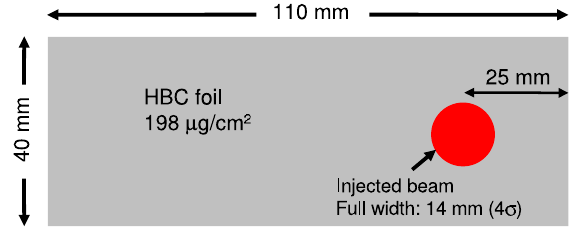
FIG. 4. The first generation primary HBC stripper foil used in the RCS was with a vertical size of 40 mm. The injected H (cid:1) beam is shown by the red circle and had a full width of 14 mm. For the present study, the injected beam was positioned in the center of the foil in the vertical direction and the edge of the foil in the horizontal direction was set as far as 25 mm from the injected beam center in order to make sure for practically no missing of the injected beam in the